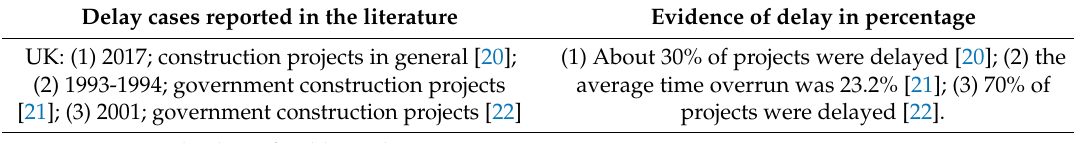
Table 2. Delay in di ff erent contexts, including the percentages of the delay reported in the